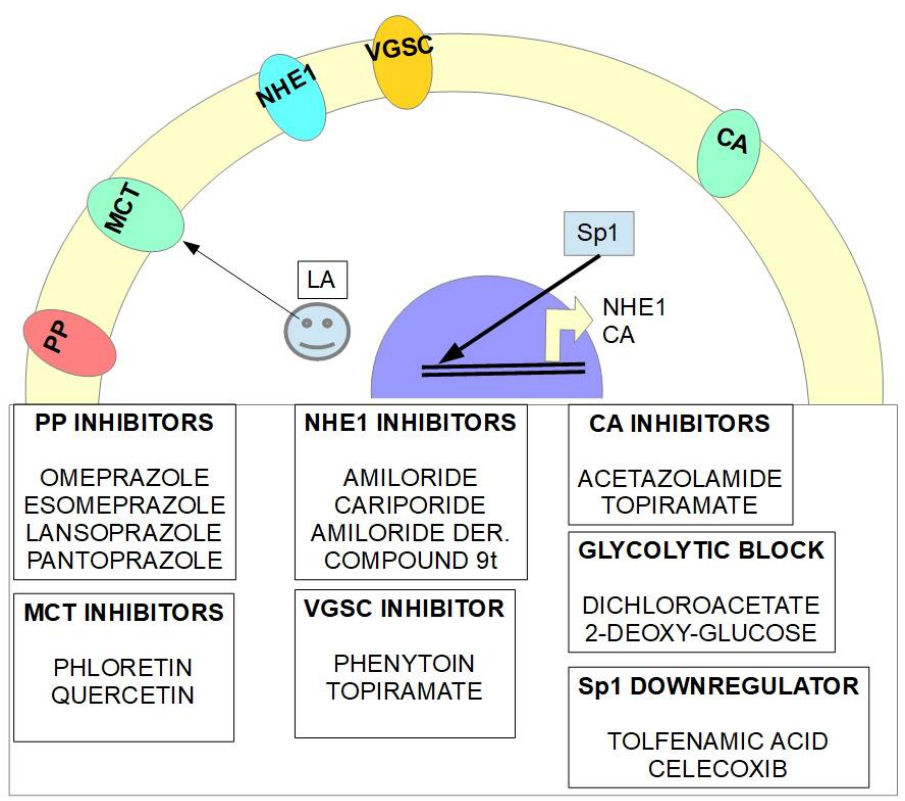
Figure 3. The combination of different proton-extruder inhibitors (“a cocktail”) are the base of the pH centered treatment of cancer with two goals: acidifying the cytoplasm and alkalinizing the extracellular pH.